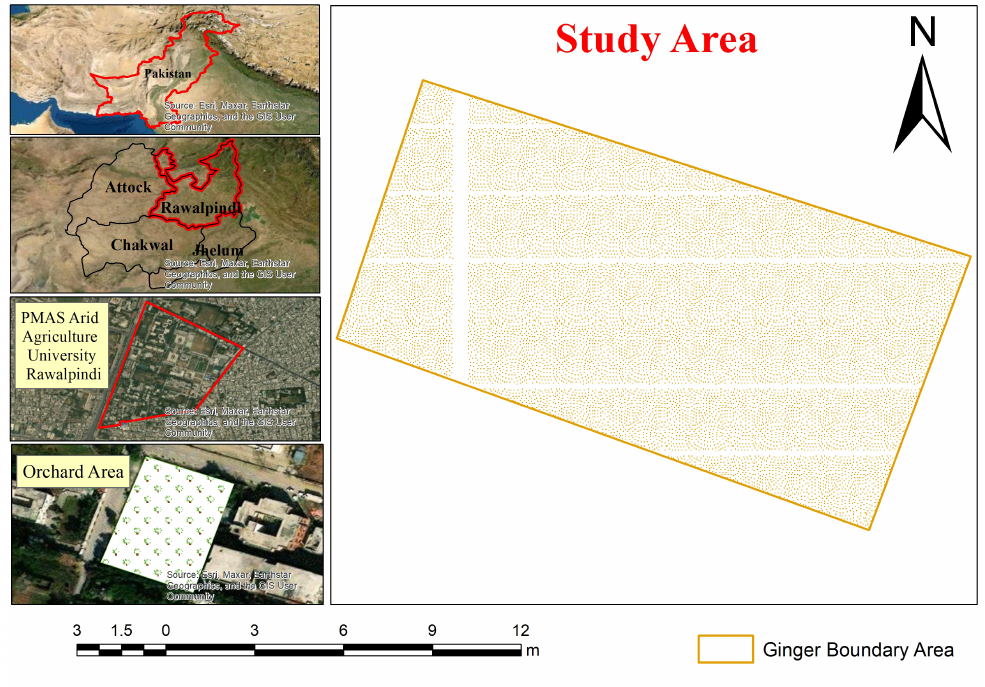
Figure 2. The study area of the collected dataset